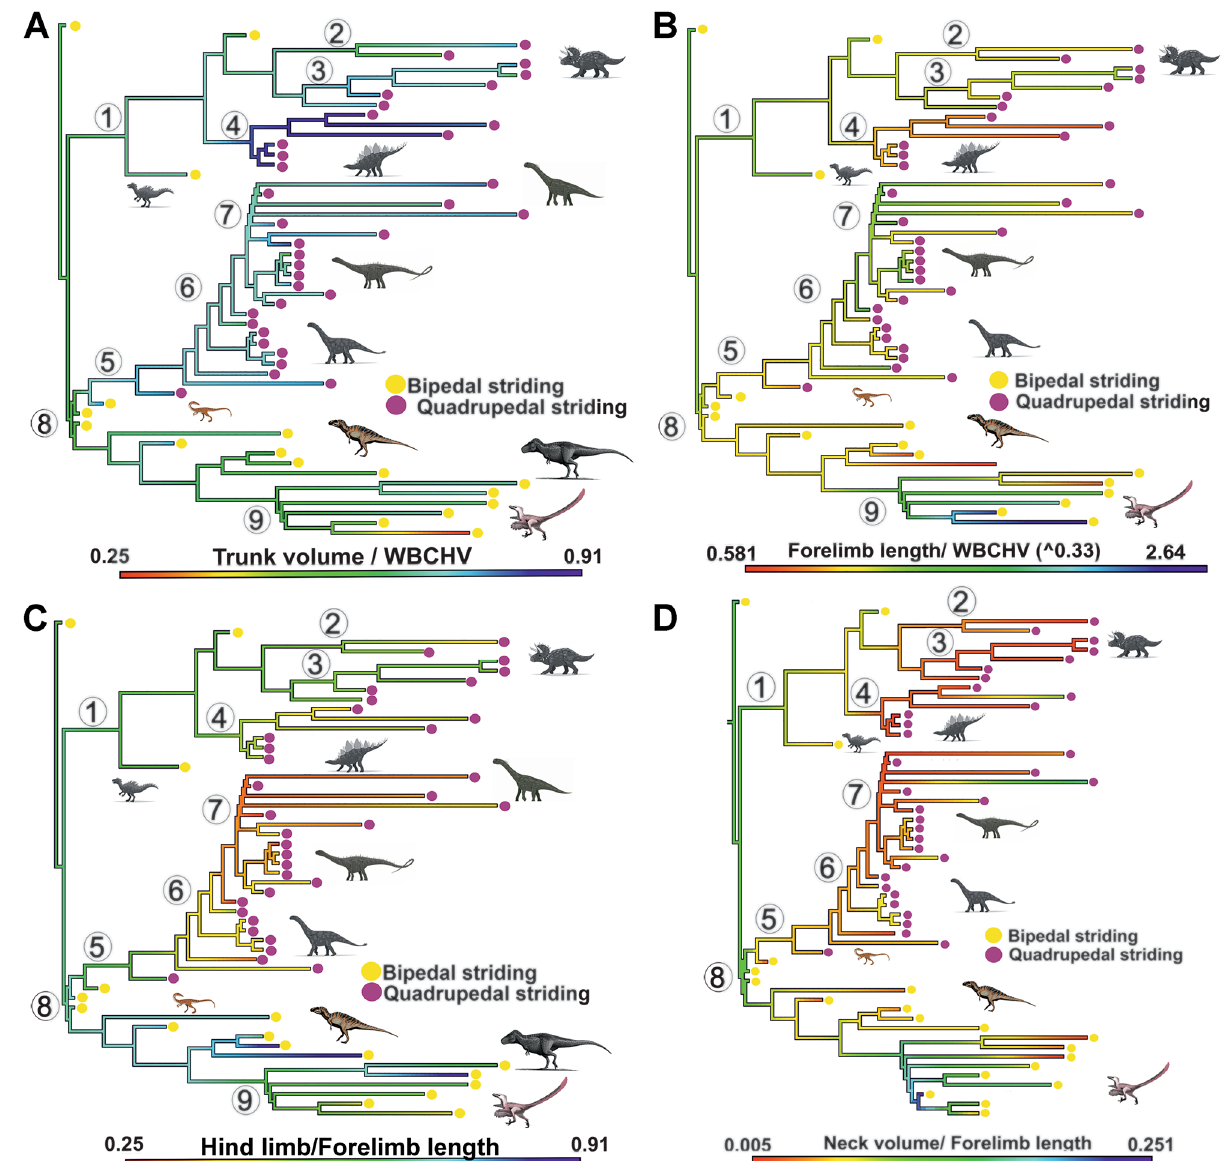
Fig. 7 | Body proportions and quadrupedality in dinosaurs. Ancestral state reconstructions of A trunk volume, B forelimb length, C hind limb to forelimb length ratio and D neck to forelimb length ratio during the transitions to quad- rupedality in Dinosauria. The patterns seen during the independent acquisition of quadrupedality in ornithischians and sauropods in the relative proportions of the torso and forelimb mirror the wider allometric patterns seen in quadrupeds and herbivores generally (Fig. 6, Hypothesis 6). Relatively short forelimbs in quad- rupedal dinosaursmayrelate to coupling of forelimb and neck lengthstomaintain